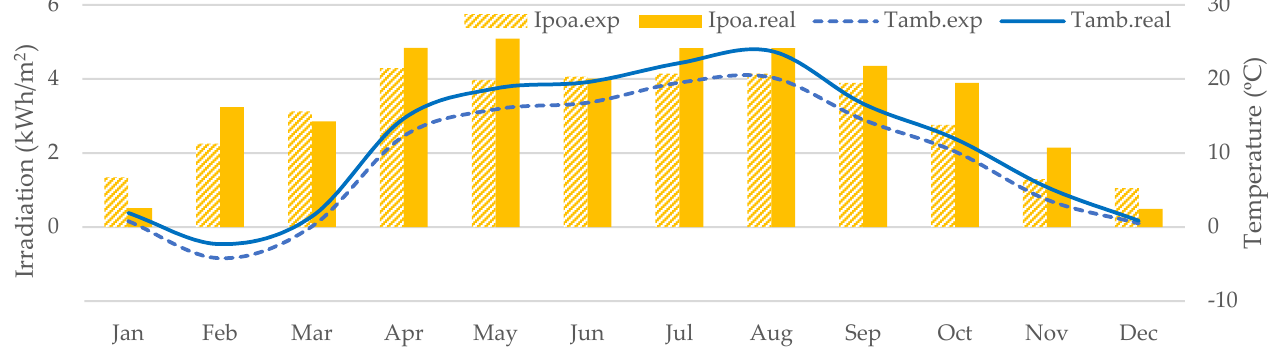
Figure 12. Day average irradiation and ambient temperature, for the initially expected values [47] and finally observed values.